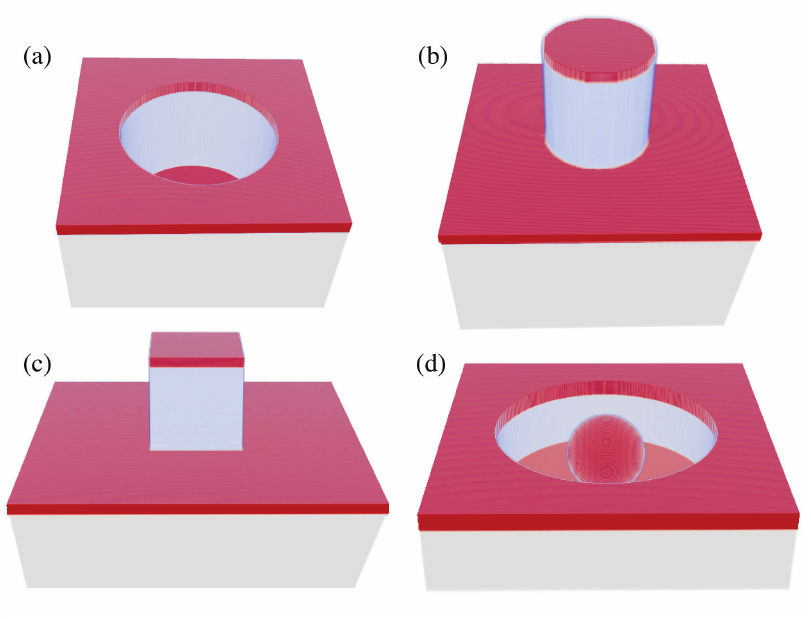
Figure 1. Unitcellgeometriesfor( a )nanowells,( b )cylindricalnanoposts,( c )squarenanoposts,and( d )particle imbedded nanowells. Plasmonic crystals result from the use of periodic boundary